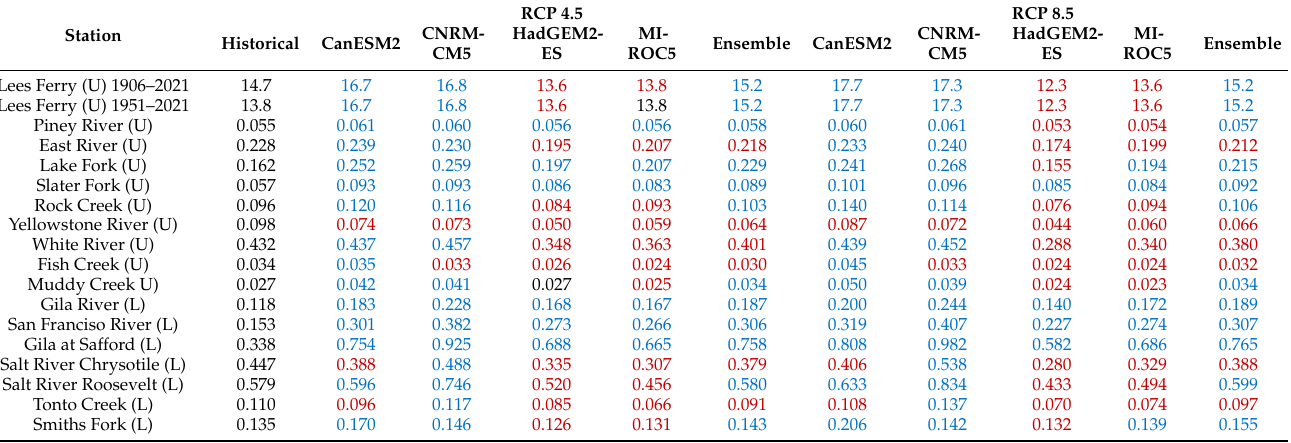
Table 4. Table of historical and future annual water year mean flow (MAF) for all eight scenarios and historical period of 1951–2021 for all stations. For Lees Ferry, the historical mean is also show for the time period 1907–2021. Ensemble means are also provided as the average of the four models for each RCP 4.5 and 8.5. Blue values are higher than the historical record and red values are lower. (Note: 1 MAF = 1233 million cubic